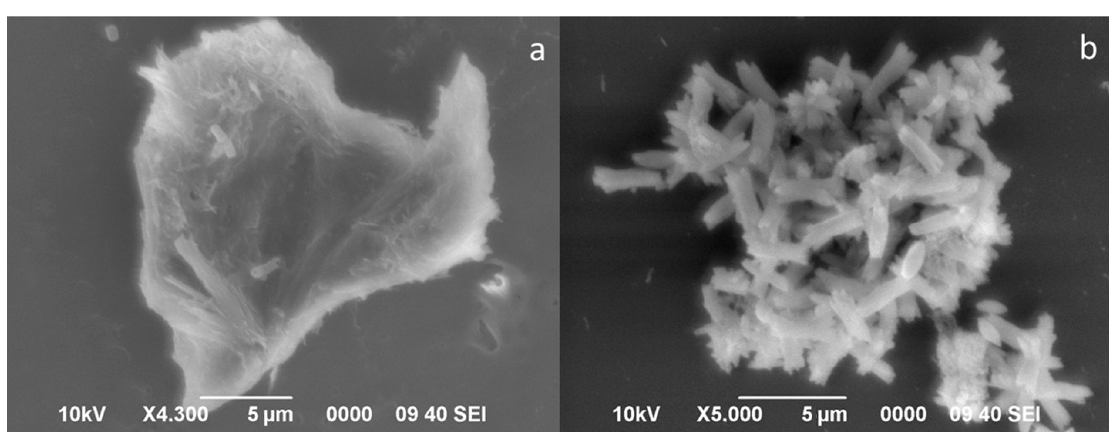
Figure 12. Adsorption kinetics of Salmonella on palygorskite and pal-PCH measured in absorbance ( A ) and concentration ( B ). The three treatments are control (grey line), palygorskite (blue line) and pal-PCH (orange line).